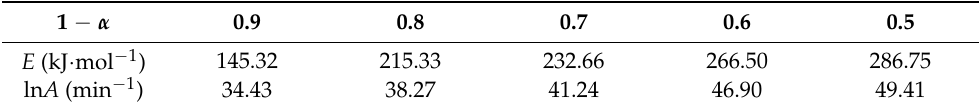
Figure 5. Plot of apparent activation energy ( E ) for BIIR decomposition in air as a function of α.